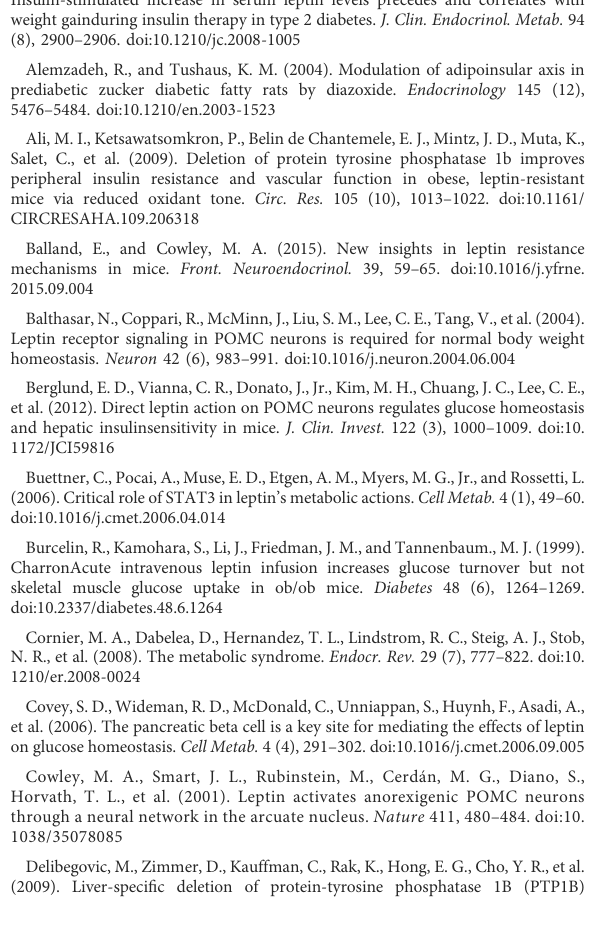
Representative hematoxylin, eosin staining or Oil red O staining of pancreas and livers from each group after treatment with APF 16 weeks or APF+lepin 3 weeks.